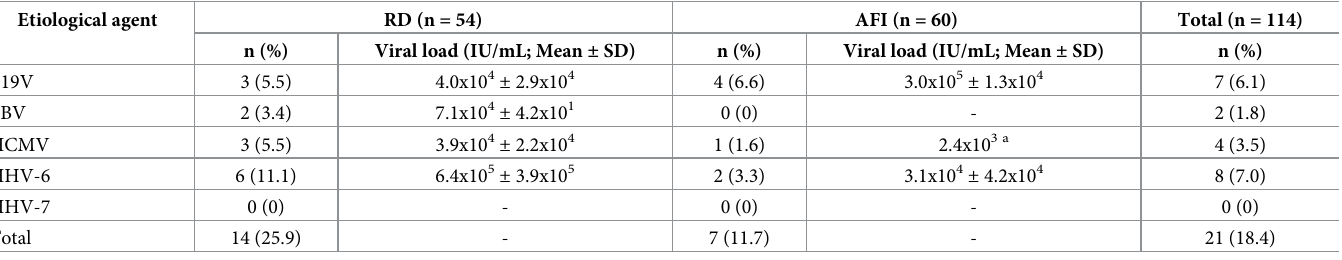
B19V: Parvovirus B19; EBV: Epstein-Barr Virus; HCMV: Cytomegalovirus; HHV-6: Human Herpesvirus 6; HHV-7: Human Herpesvirus 7; IU/mL: International